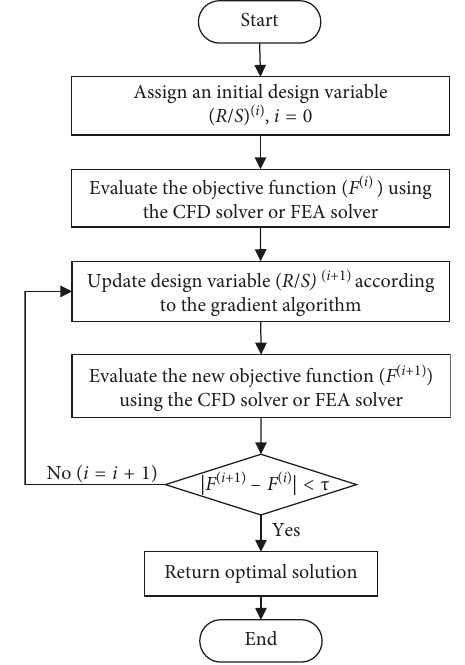
Figure 6: Flow chart of the aerodynamic optimization